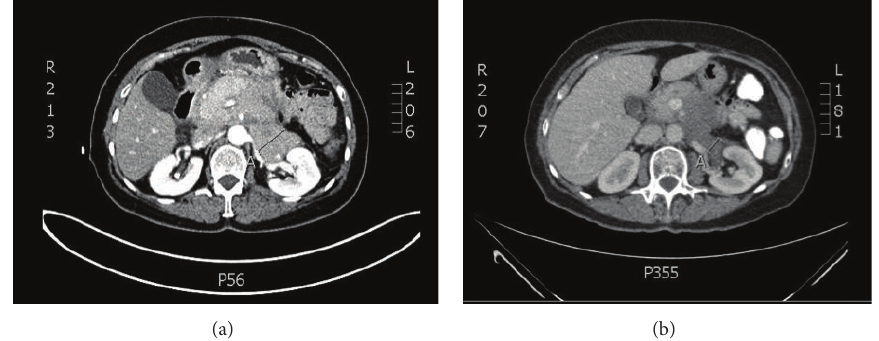
Figure 2: CT abdomen shows a confluent lymphoma mass commencing at the celiac trunk and extending inferiorly to the pelvic outlet (a) before and (b) after radiotherapy.